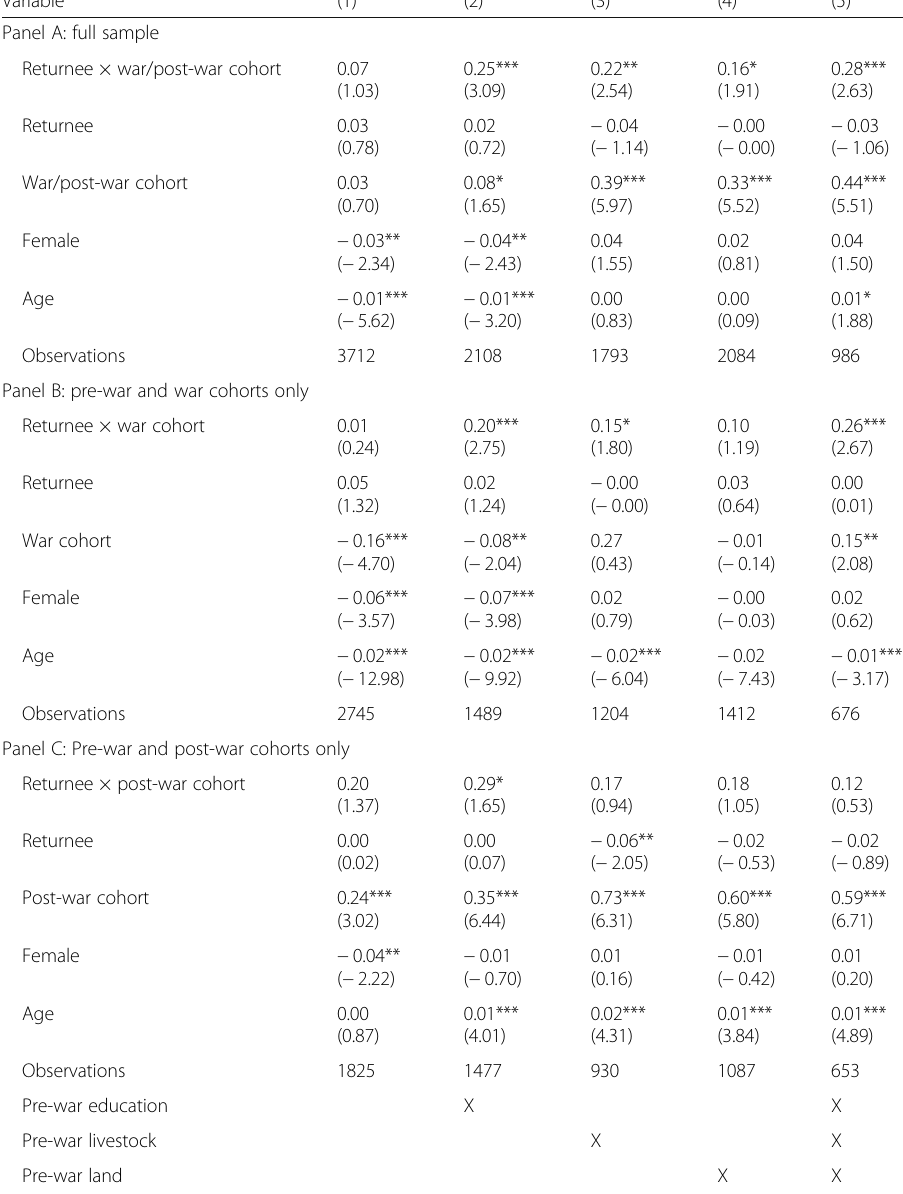
Table 4 Impact refugee experiences on likelihood of finishing primary school Variable